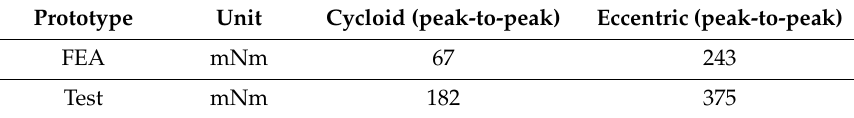
Table 6. Cogging torque for FEA and test results considering rotor tolerance.